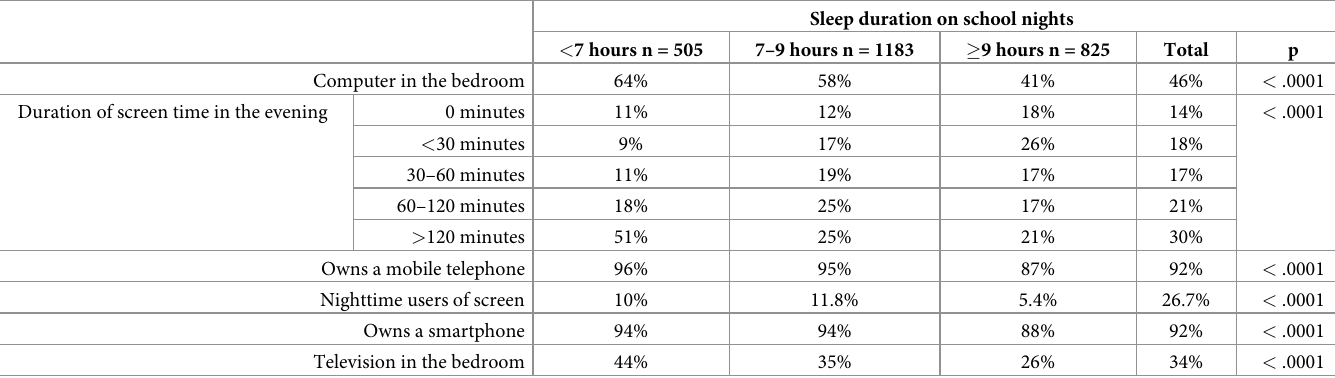
Table 2. The association between screens and sleep